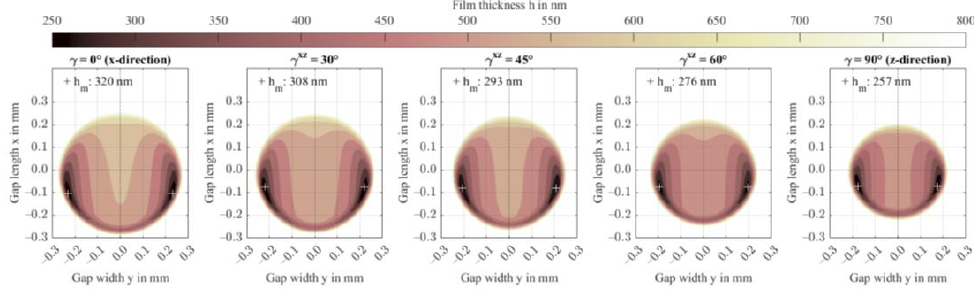
Figure A2. Film thickness contours including minima for variation of the fiber orientation 𝛾 𝑥𝑧 in the xz-plane.